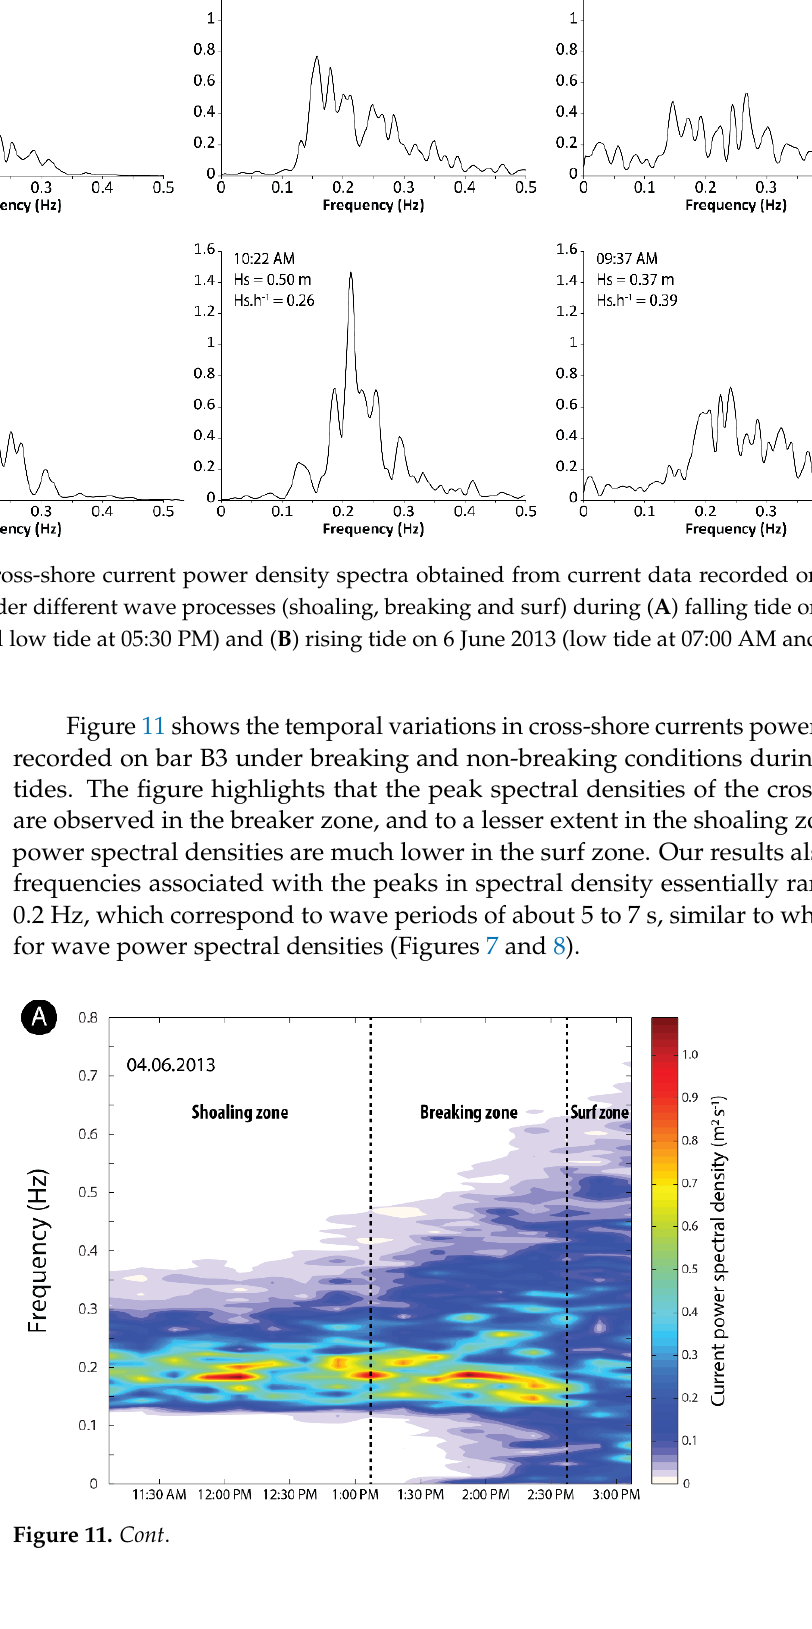
Figure 11. Temporal variations in frequency and power spectral density of cross-shore currents over bar B3 (see Figure 2D for location) under non-breaking and breaking wave processes as water depth